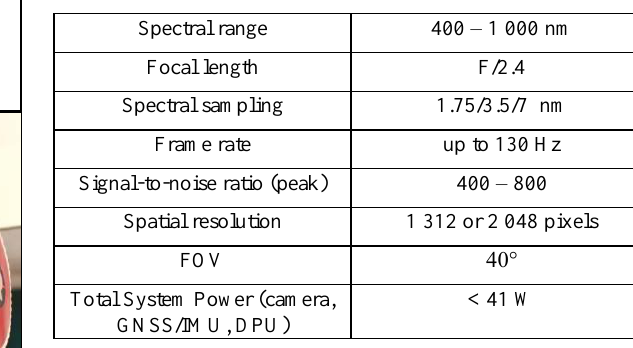
Table 1: Parameters of the hyperspectral